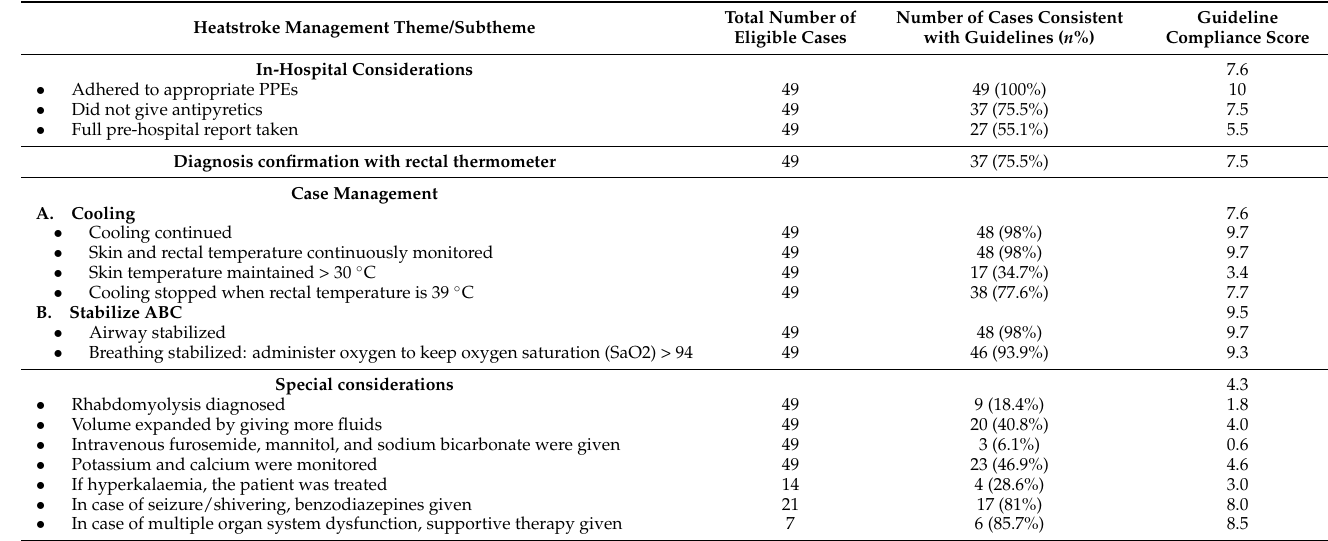
Table 4. Heatstroke in-hospital management guidelines compliance scores ( n =